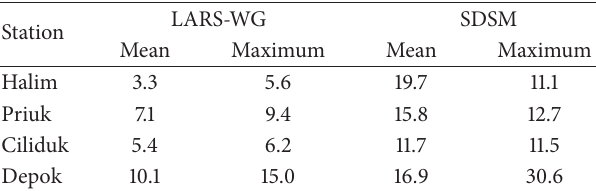
Table 3: Percentage error in daily mean and maximum rainfall averaged over 12